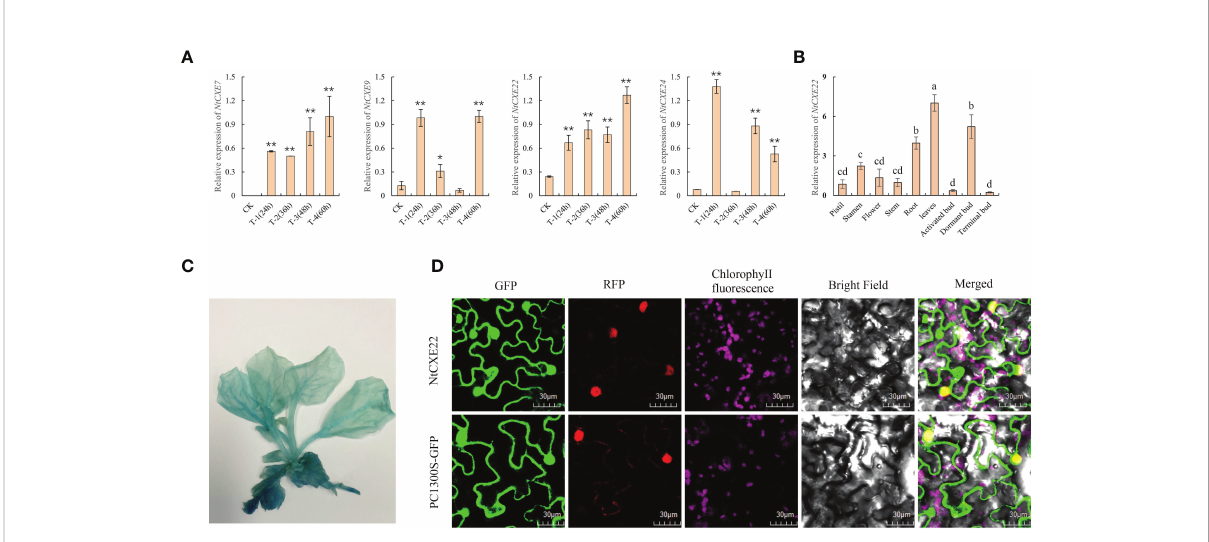
FIGURE 8 Expression patterns of NtCXE22 and subcellular localization of the NtCXE22 protein. (A) qRT-PCR quantitative analysis of NtCXE7 , NtCXE9 , NtCXE22 , and NtCXE24 genes at different time points after topping, compared with that before topping. Data are presented as means ± SDs (n = 3). *P < 0.05, **P < 0.01 (signi fi cant difference between the topping treatment and control, based on Student ’ s t-test). (B) qRT-PCR quantitative analysis of NtCXE22 in different tissues. Data are presented as means ± SDs (n = 3). Different letters indicate signi fi cant differences between various tissues, based on one-way ANOVA. (C) Histochemical analysis of GUS expression driven by proCXE22. (D) Subcellular localization of NtCXE22